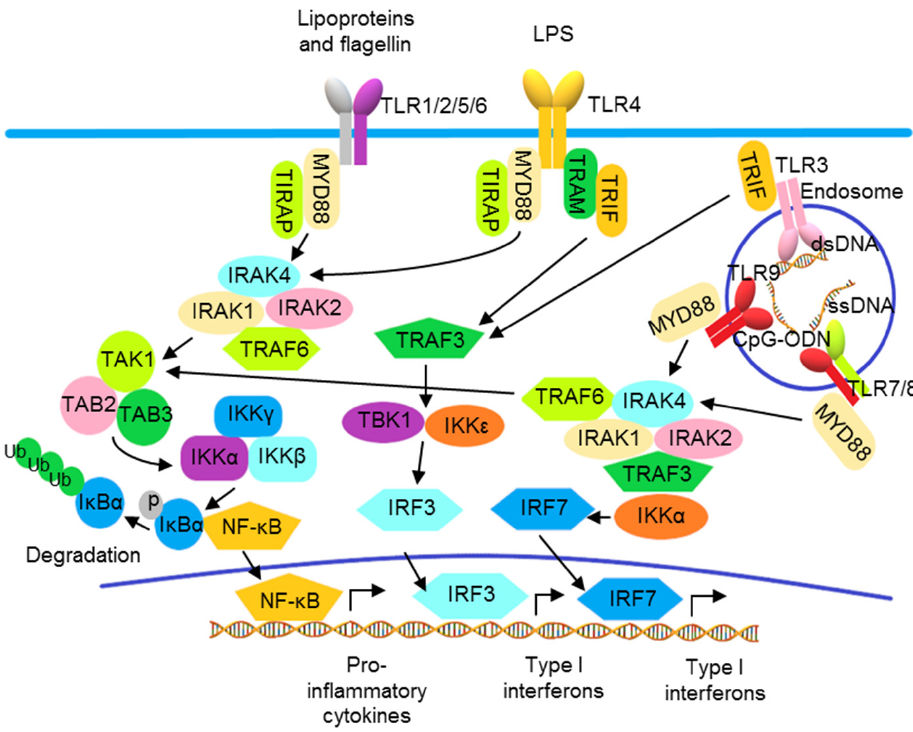
Figure 2. Toll-like receptor signaling pathways. TLRs 1, 2, 4, 5, and 6 localize to the cell surface, and TLRs 3, 7, 8, and 9 localize to intracellular vesicles, such as endosomes, where they recognize their ligands, including exogenous pathogen-associated molecular patterns (PAMPs) and endogenous damage-associated molecular patterns (DAMPs). The TLRs use the adaptor proteins of the MyD88 family, including MyD88, TRIF, TIRAP, and TRAM, to initiate downstream signaling pathways, leading to the activation of various transcription factors, including IRF3/7 and NF- κ B, and the production of type I interferons and pro-inflammatory cytokines.